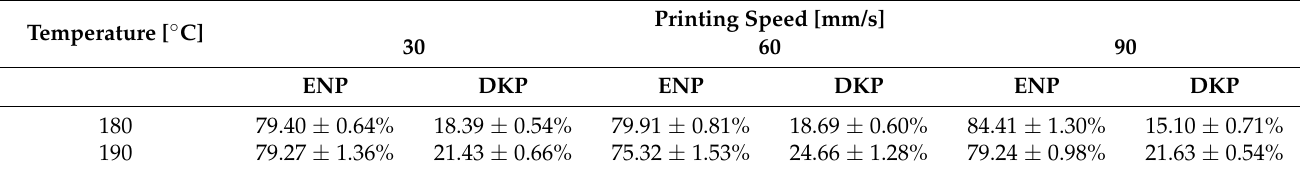
Table 4. Enalapril (ENP) and diketopiperazine derivative (DKP) contents in the FDM printed tablets with a nozzle diameter of 0.6 mm printed at 180 ◦ C (a) and 190 ◦ C (b) with different printing speeds (n = 10, mean ±